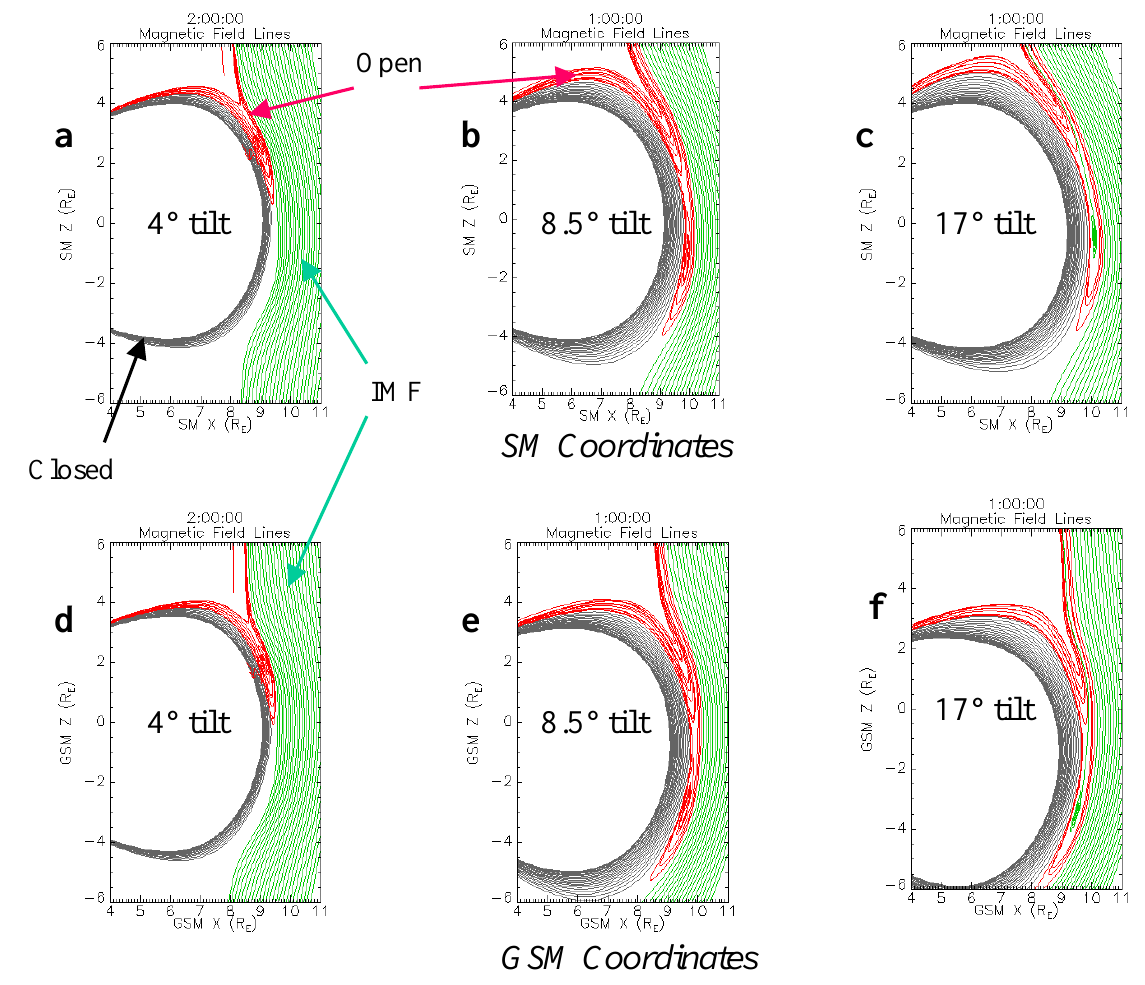
Fig. 19. Traced magnetic field lines using MHD simulations with three different dipole tilt angles using ISM. Black field lines are closed. Red field lines are open with one foot in the Northern Hemisphere. Green field lines have both feet in the solar wind. The results are presented in both SM and GSM